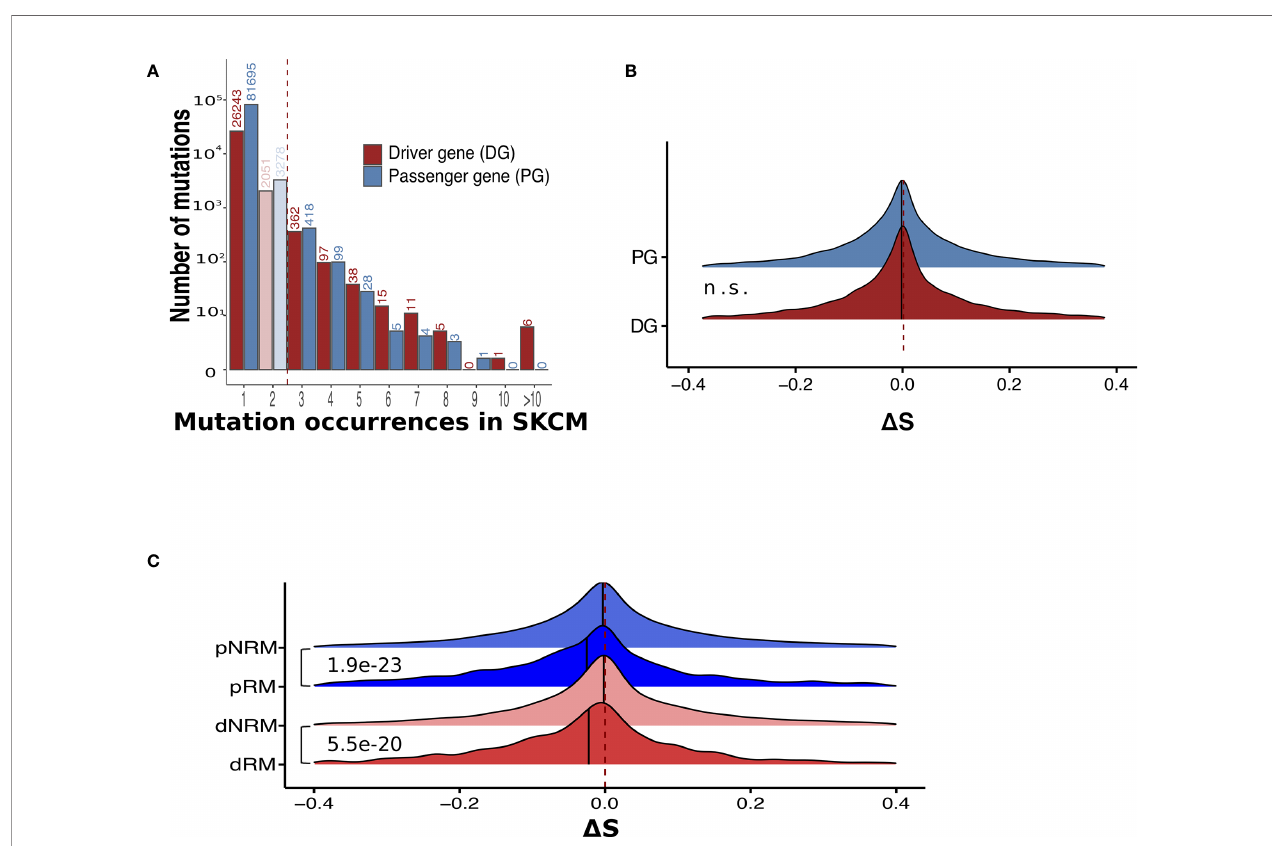
FIGURE 3 | Recurrent mutations have signi fi cantly lower D S than non-recurrent mutations in both driver and passenger genes. (A) The distribution of occurrences of non-synonymous mutations in melanoma samples. Mutations presenting in driver and passenger genes are separated. (B) No signi fi cant D S difference between somatic mutations in driver and passenger genes. n.s., not signi fi cant. (C) Comparison of D S between recurrent and non-recurrent mutations in driver and passenger mutations. dRM, recurrent mutation in driver genes; dNRM, non-recurrent in driver genes; pRM, recurrent mutation in passenger genes; pNRM, non-recurrent in passenger genes. P-values were calculated using two-sided Wilcoxon rank-sum